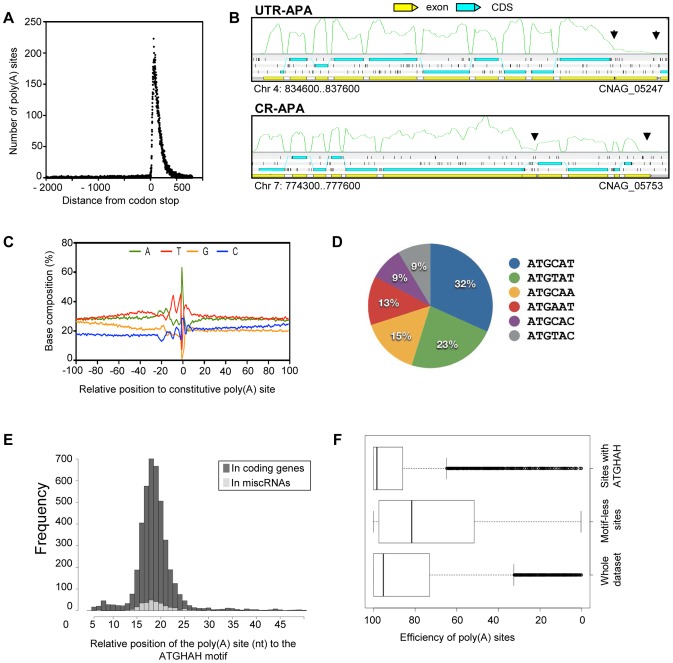
Polyadenylation sites in C. neoformans var. grubii.
A. Poly(A) reads are enriched within 500 nt from the stop codon of the gene models. B. Examples of CR-APA and UTR-APA as visualized through Artemis. The black arrows indicate the position of the alternative poly(A) sites. The green curves indicate the plus strand coverage. The small black vertical bars indicate the position of the stop codons for each frame. C. Sequence composition around the poly(A) cleavage sites. D. Proportion of the variants of the AUGHAH motif. E. Relative position of the poly(A) site (nt) to the AUGHAH motif in coding genes and miscRNAs. F. Efficiency of the poly(A) sites to induce transcription termination according to the presence or absence of an AUGHAH motif.